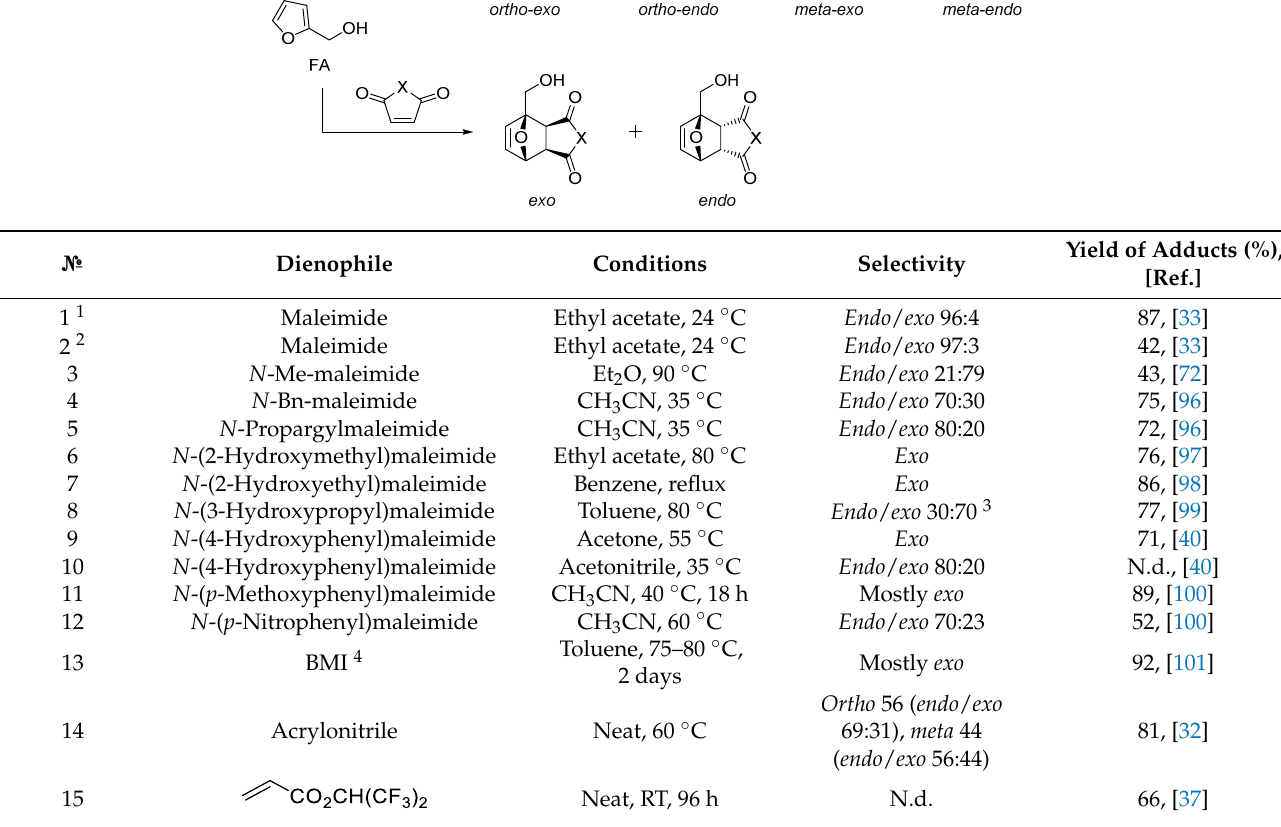
Table 4. IMDA cycloadditions of FA with alkenes.